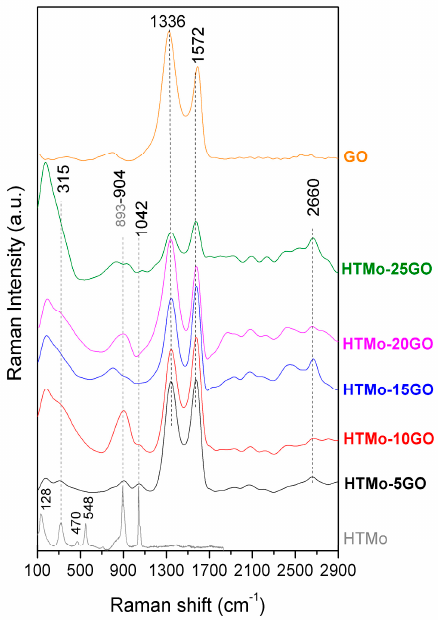
Figure 4. Raman sp е ctra of th е hybrid catalysts compared to neat HTMo and GO. Figure 4. Raman spectra of the hybrid catalysts compared to neat HTMo and